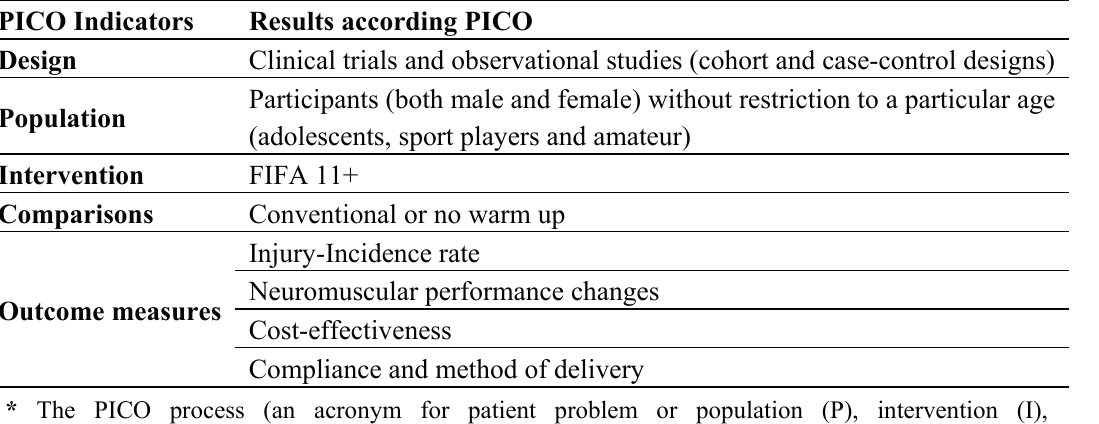
Table 1. Inclusion criteria according to the PICO acronym *